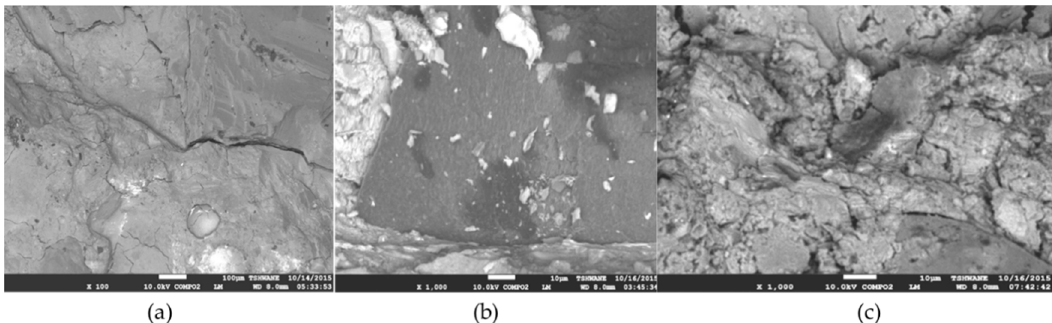
Figure 8. SEM images of rubberized ECC containing ( a ) 0% CR, ( b ) 5% CR, and ( c ) 10% CR.